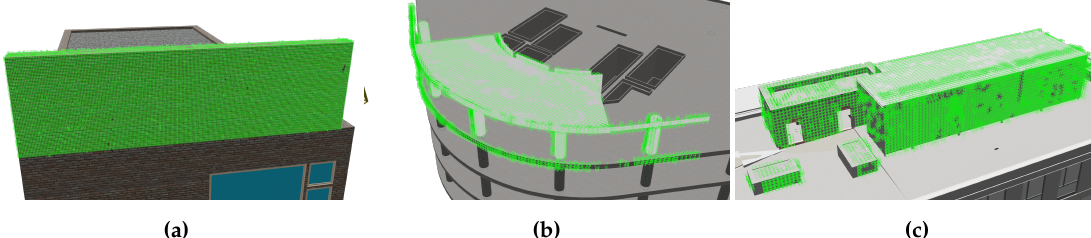
Figure 9. Results of true positive tests (scenario 1). Structural objects are indicated by the schedule and fully present in the as-built scenes. Green annotations show octree leafs that were correctly matched during flight. ( a ) a single wall in scene 1 (94.8%). ( b ) multiple columns and a slab in scene 2 (76.53%). ( c ) a complete structure on a roof in scene 3